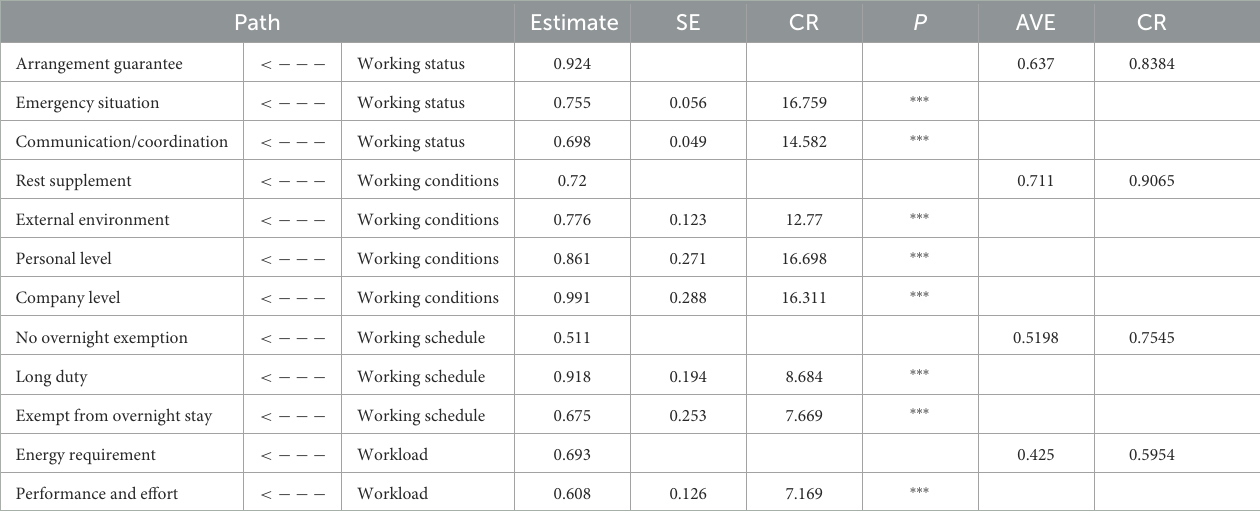
TABLE 8 Factor loading value, convergent validity and combined reliability information of the path analysis model of fatigue-influencing factors in the “work” dimension of long-haul flight